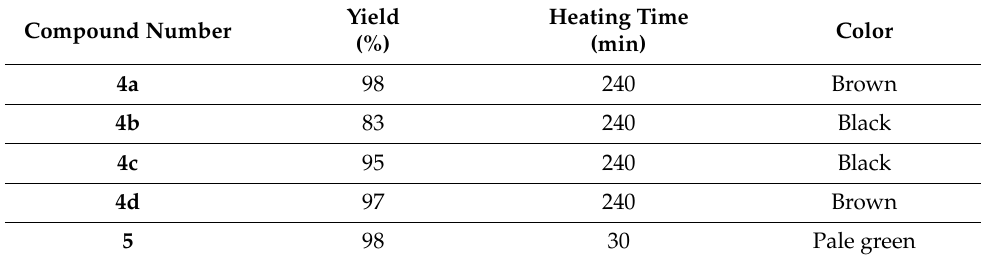
Table 2. Physical data of compounds 4a–d , 5